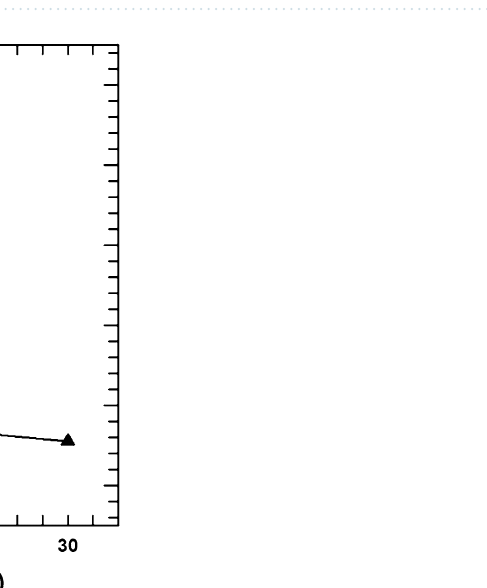
Figure 6. ( a ) Electrical conductivity, ( b ) Seebeck coefficient, and ( c ) power factor of composite sample with various AS contents.